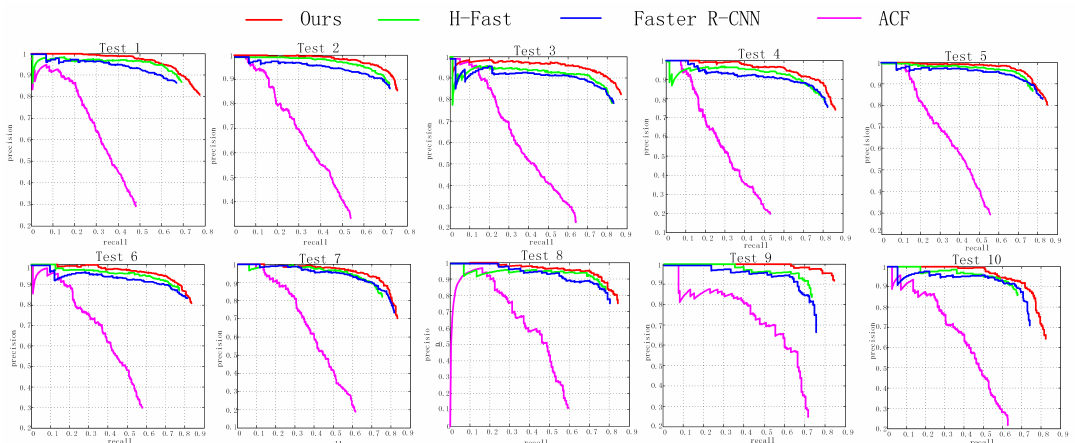
Figure 9. precision-recall curve (PRC) of the proposed method and other state-of-the-art approaches for vehicle detection in 10 test images, respectively.